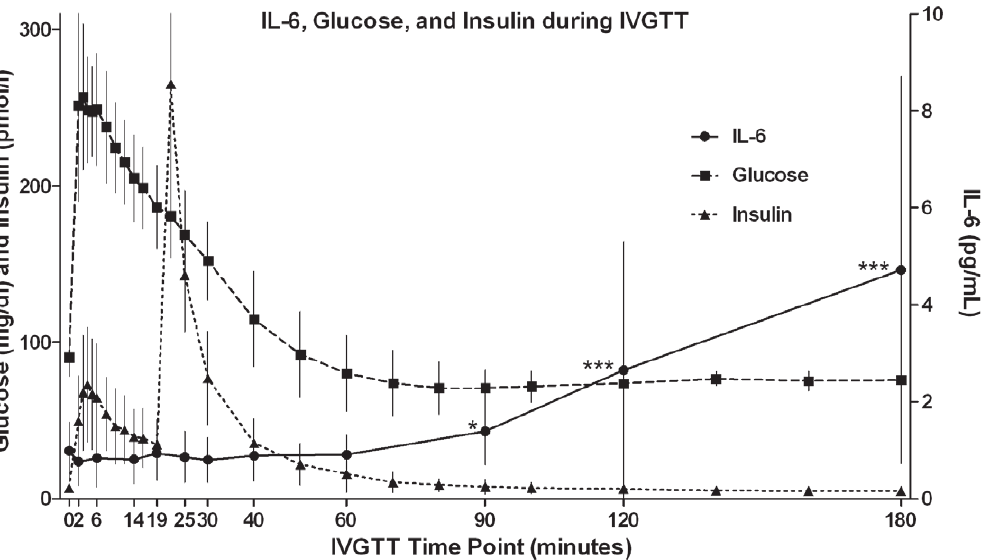
Figure 3. Plasma glucose, insulin, and IL-6 during frequently sampled intravenous glucose tolerance test (IVGTT). Plasma concentrations of glucose ( & ) and insulin ( m ) (defined by the left Y axis) and IL-6 as measured by Meso Scale Discovery ( N ) (defined by the right Y axis) are shown. Glucose (50%, 0.3 g/kg body mass) was infused at time zero, and insulin (0.025 U/kg body mass) was infused at 20 minutes. Measurements are mean (SD) for n=fourteen subjects; * p value , 0.05; ** p value , 0.01 as compared to baseline. Figure S1 Plasma IL-6 during frequently sampled intravenous glucose tolerance test (IVGTT) in subject Figure S2 Plasma IL-6 during frequently sampled intravenous glucose tolerance test (IVGTT) in subject Figure S3 Plasma IL-6 during frequently sampled intra- venous glucose tolerance test (IVGTT) in subject 3. Plasma concentrations of IL-6 were measured by MesoScale Discovery ( MSD), R&D High Sensitivity ELISA ( & R&D), and Invitrogen Luminex ( m LX) and Invitrogen Ultrasensitive Luminex ( 6 ULX).